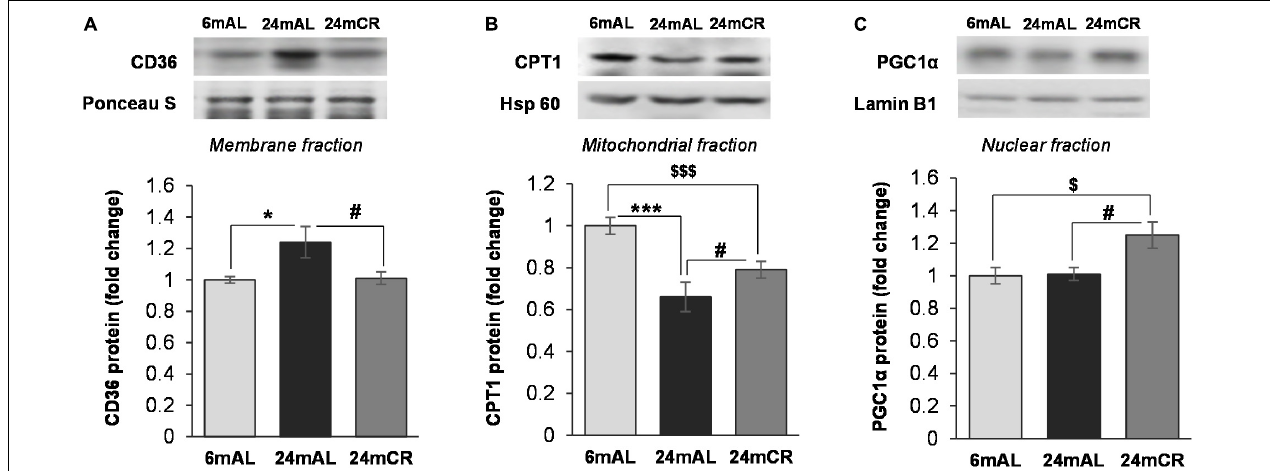
FIGURE 2 | The levels of proteins involved in FA transport and β -oxidation. Representative Western blots and relative quantification of CD36 level in membrane fraction (A) , CPT1 level in mitochondrial (B) , and PGC1 α level in nuclear fraction (C) of the liver of adults (6 mAL), aged rats on AL diet (24 mAL) and old rats on CR (24 mCR). Ponceau S, Hsp 60, and Lamin B1 were used as loading controls for membrane, mitochondrial, and nuclear fraction, respectively. All values are given as means ± SEM ( n = 8). Asterisk indicates a significant difference between aged rats on AL diet and adults (24 mAL vs. 6 mAL, * p < 0.05, *** p < 0.001), hashtag